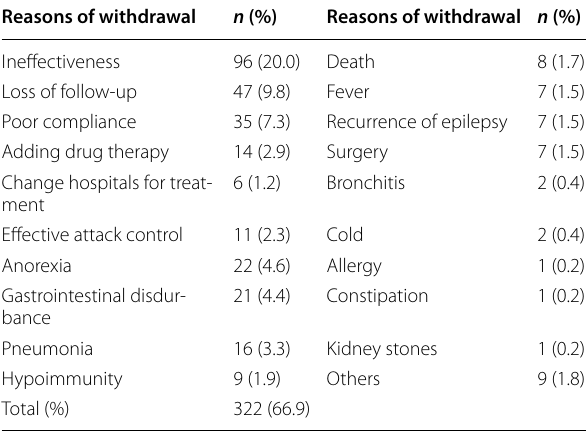
Table 5 Causes of KD withdrawal in 481 infantile spasm patients within 12